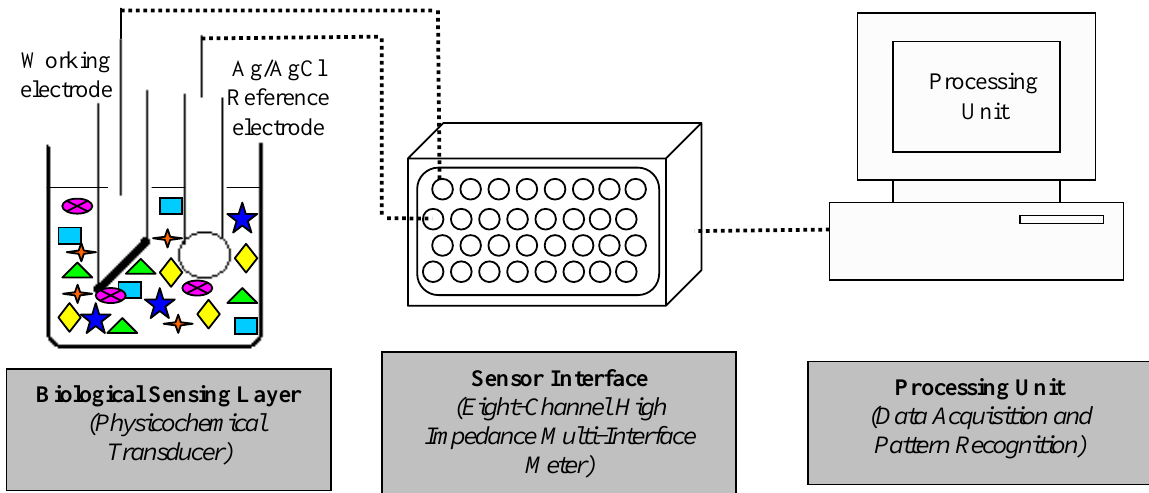
Figure 1. Schematic diagram of the artificial lipid-polymer membrane based sensor